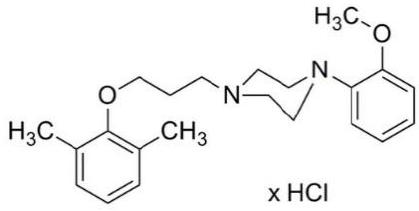
Figure 1. Structure of MH-76.